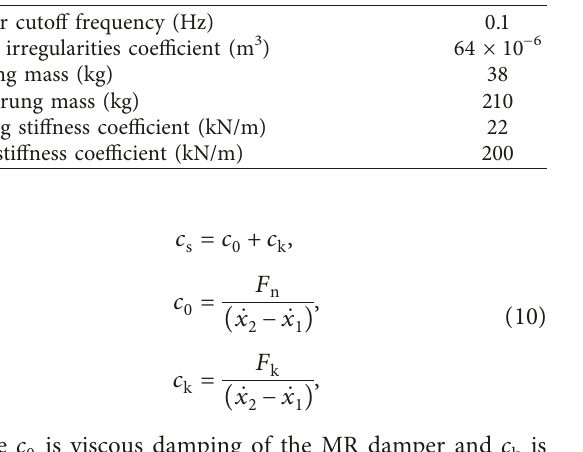
Table 1: Simulation parameters of the hybrid suspension. Parameters